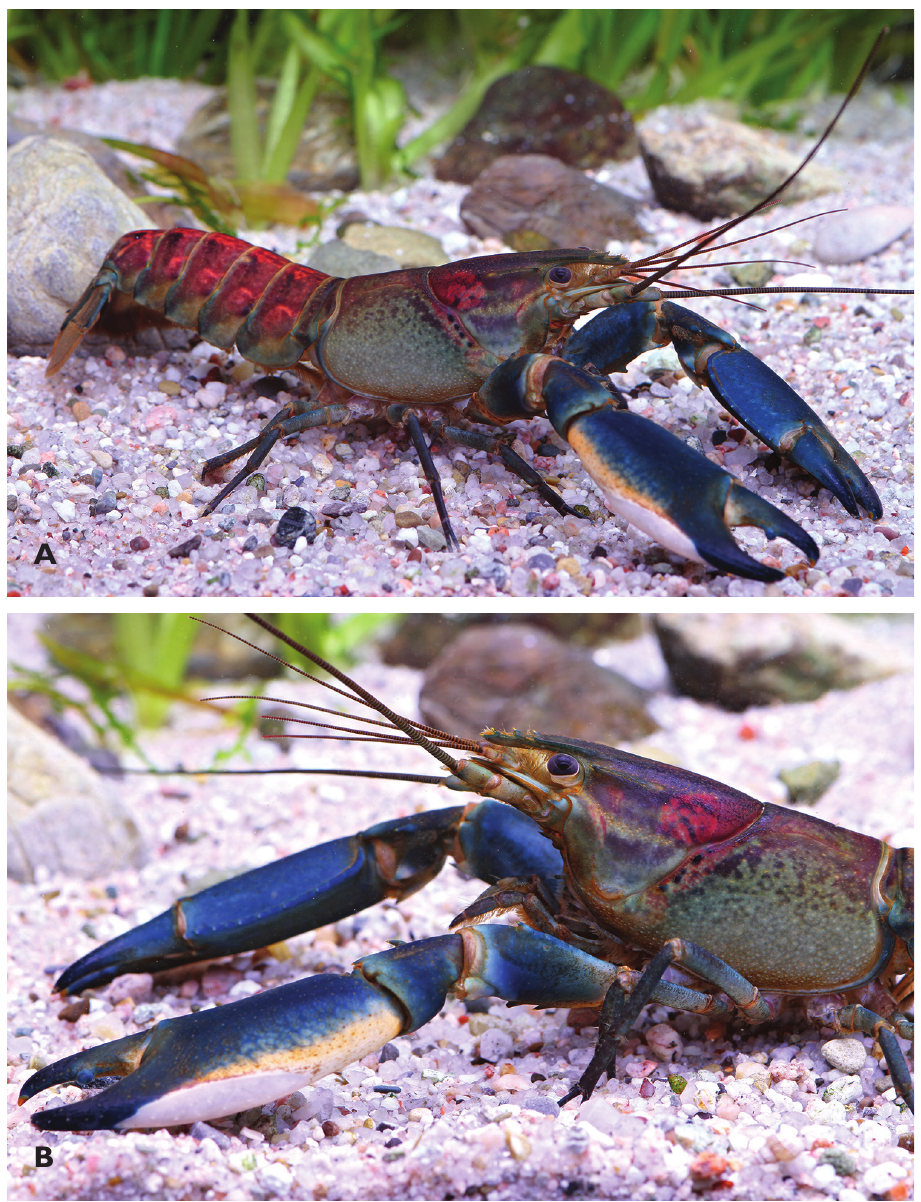
Figure 1. Cherax warsamsonicus sp. n. A holotype male (MZB Cru 4529) from the Warsamson River, South Sorong Regency B idem, side